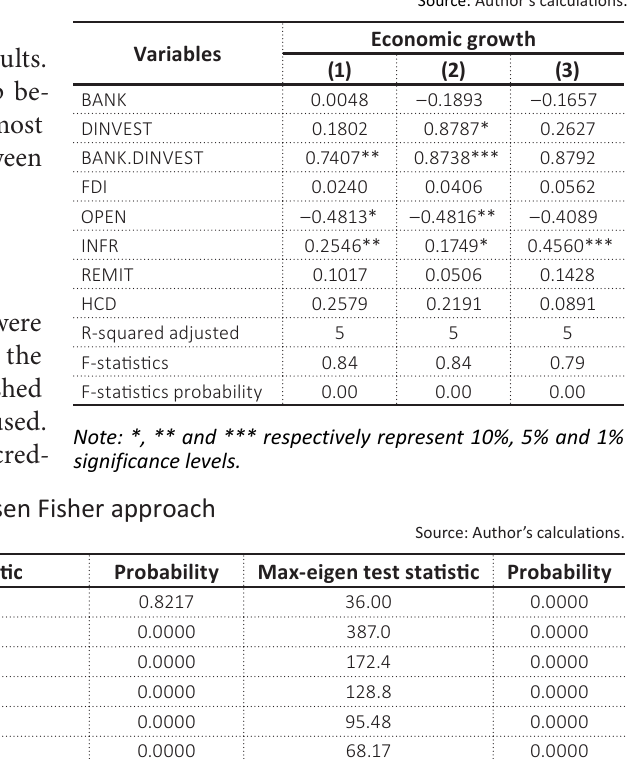
Table 4. FMOLS results